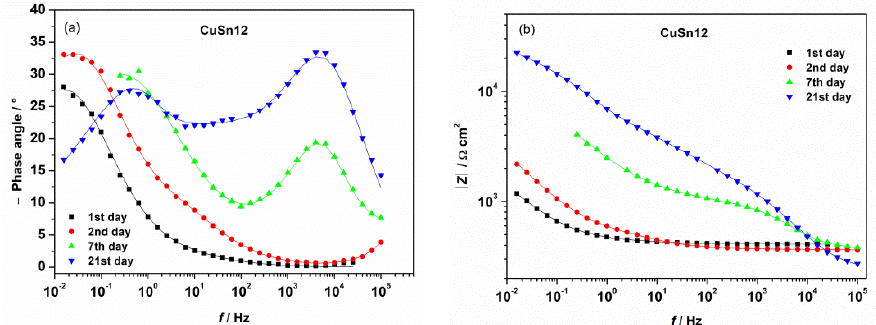
Figure 1. EIS spectra for CuSn12 for continuous immersion in simulated acid rain at pH 5. ( a ) Bode phase angle; ( b ) Bode impedance.